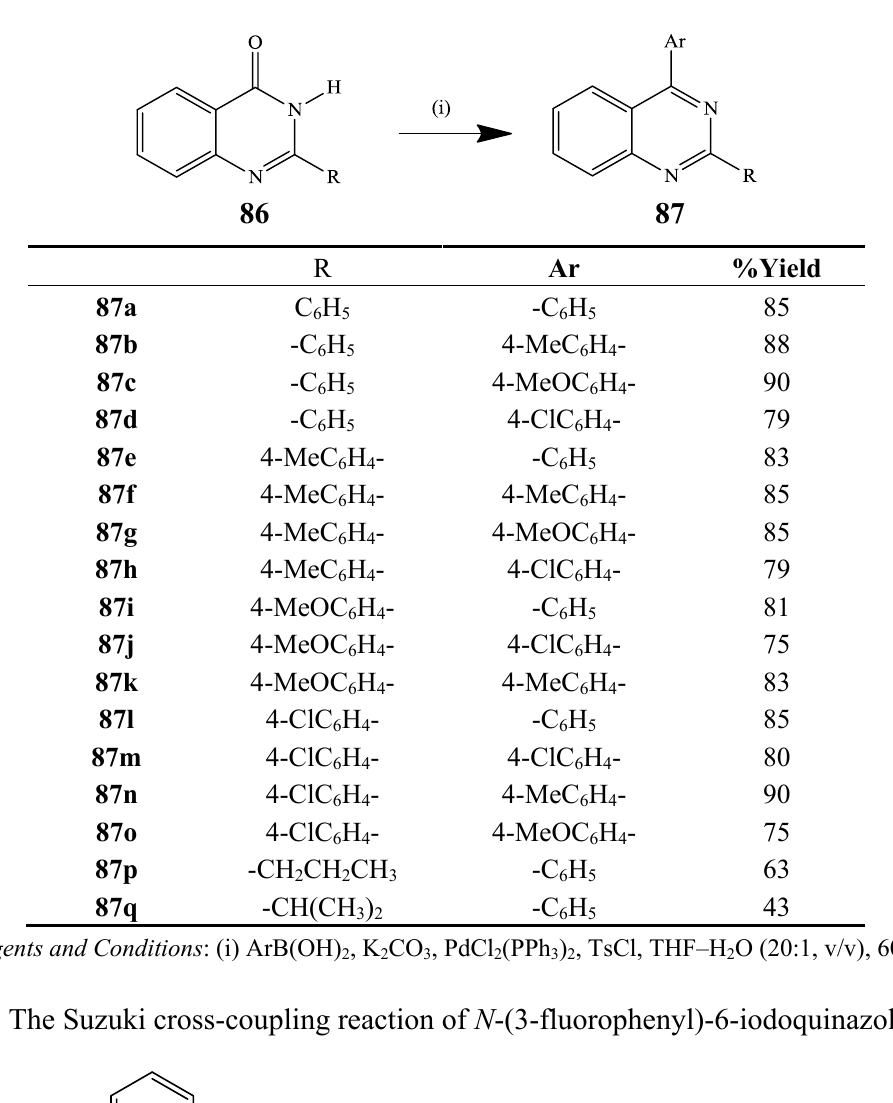
Scheme 28. Suzuki-Miyaura cross-coupling of tosylates generated in situ from 86 .